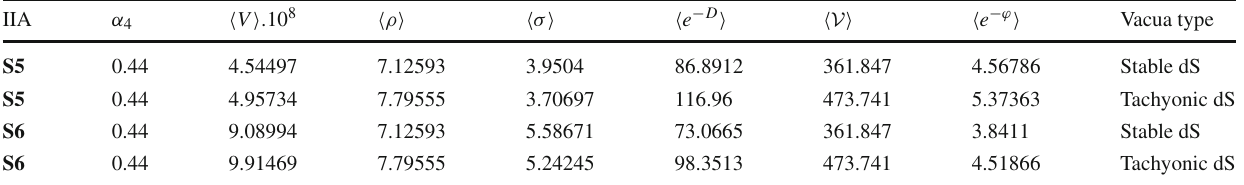
Table 7 Numerical samplings for the two new benchmark model defined in Eq. (3.27) which give stable and tachyonic dS solutions for integral valued fluxes and the triple intersection